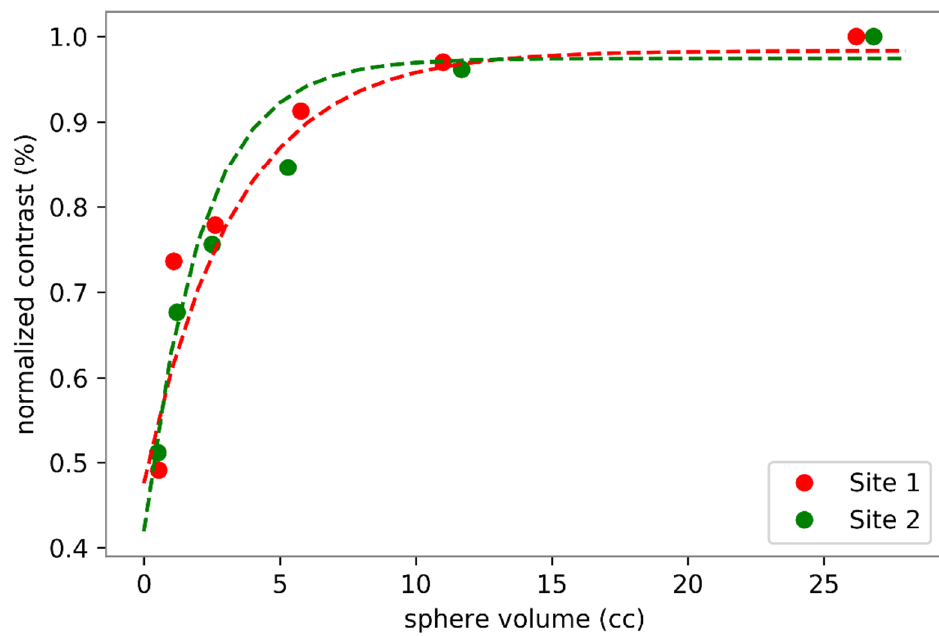
Figure 4. Quantitative assessment of FDG PET images obtained at site 1 (GE Discovery 690 PET scanner) and at site 2 (Siemens Biograph mCT 64 PET scanner). Sphere volumes correspond to sphere diameters of 10, 13, 17, 22, 28 and 37 mm.